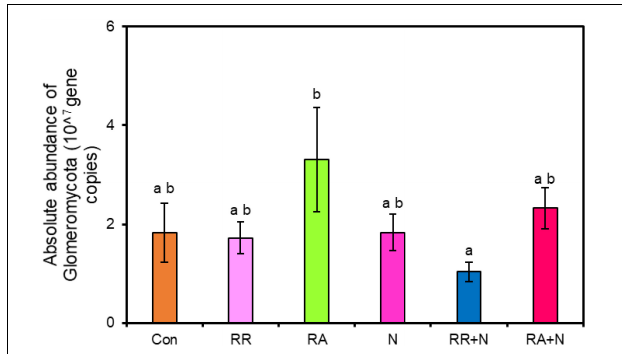
FIGURE 6 | The effects of nitrogen addition and rainfall and their interaction on the absolute abundance of Glomeromycota. Different treatments: Con: Control; RR: Rainfall reduction; RA: Rainfall addition; N: Nitrogen addition; RR + N: Rainfall reduction and Nitrogen addition; RA + N: Rainfall addition and Nitrogen addition. Values are mean ± SE ( n = 5). Different lowercase letters indicate significant differences ( p < 0.05) according to Duncan’s post hoc